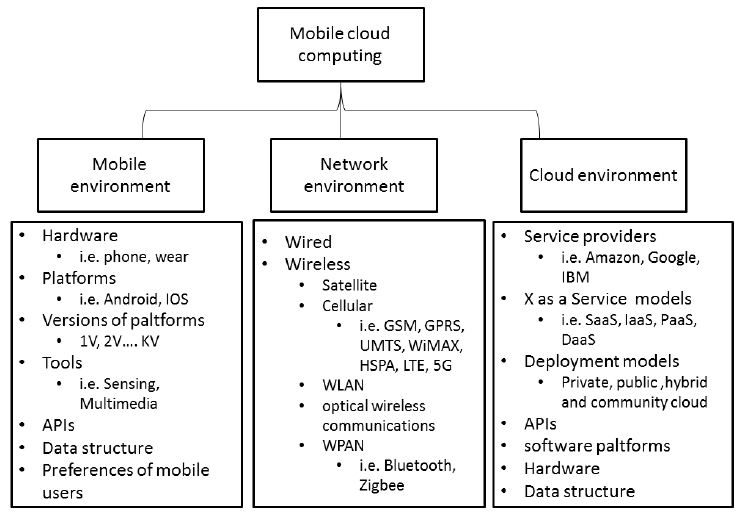
Figure 3. Diversity in the mobile cloud environment.